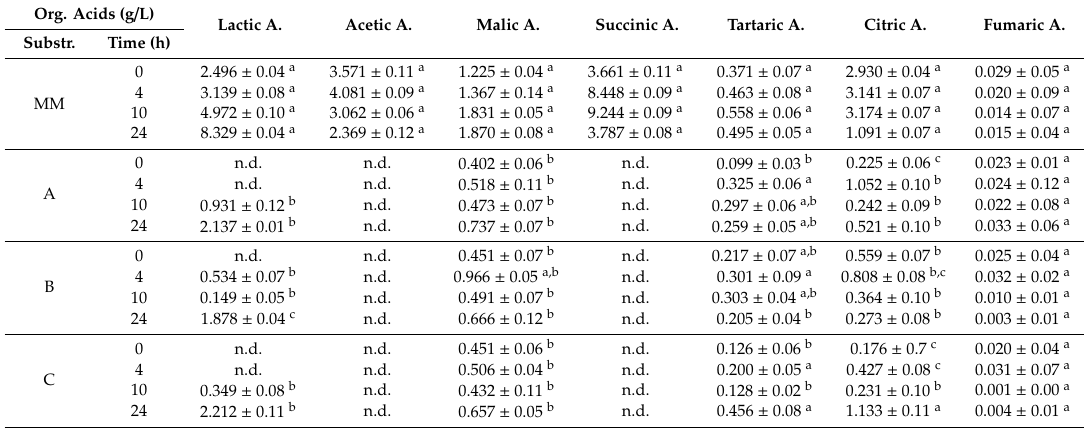
Table 3. Organic acid production through fermentation with Lc.